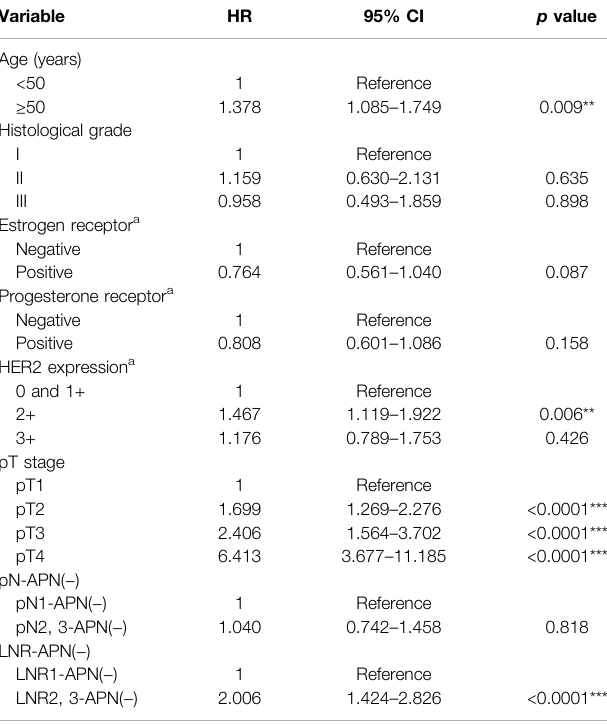
TABLE 2 | Overallsurvivalmultivariable analysisofAPN( − )patientsamong10,120 breast cancer patients. Variable